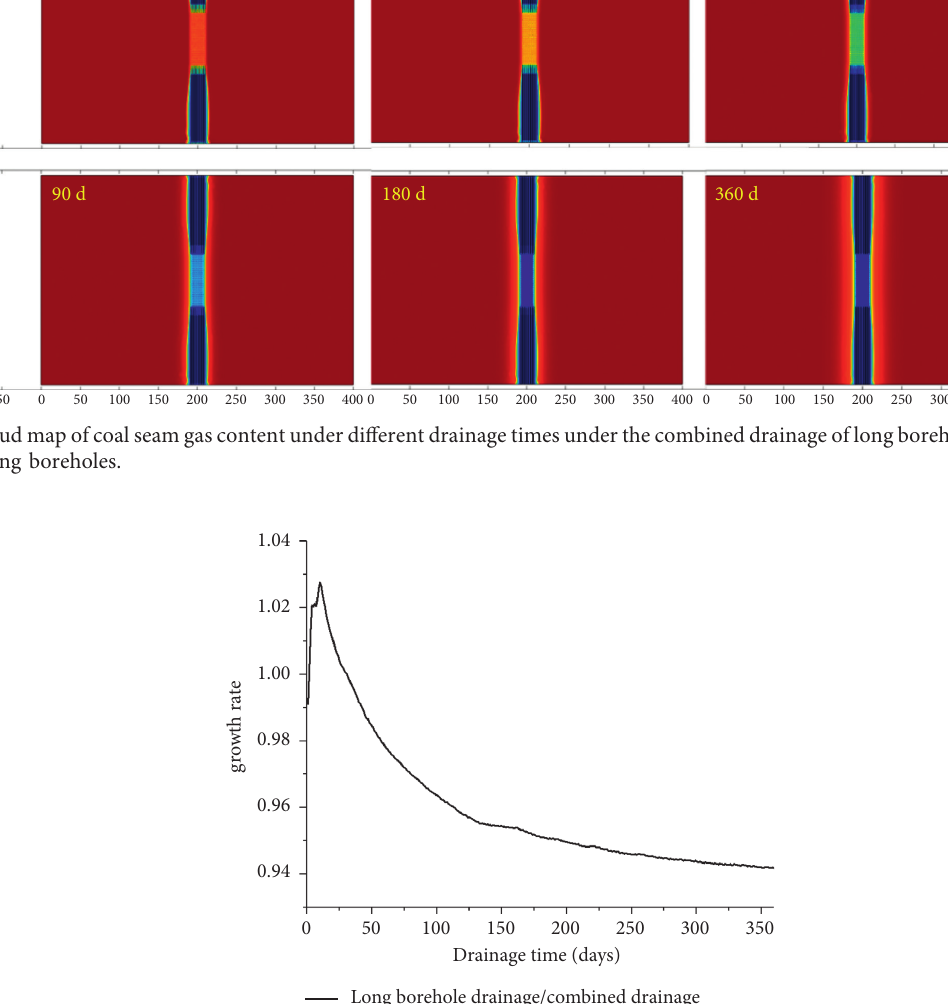
Figure 7: Long boreholes drainage growth